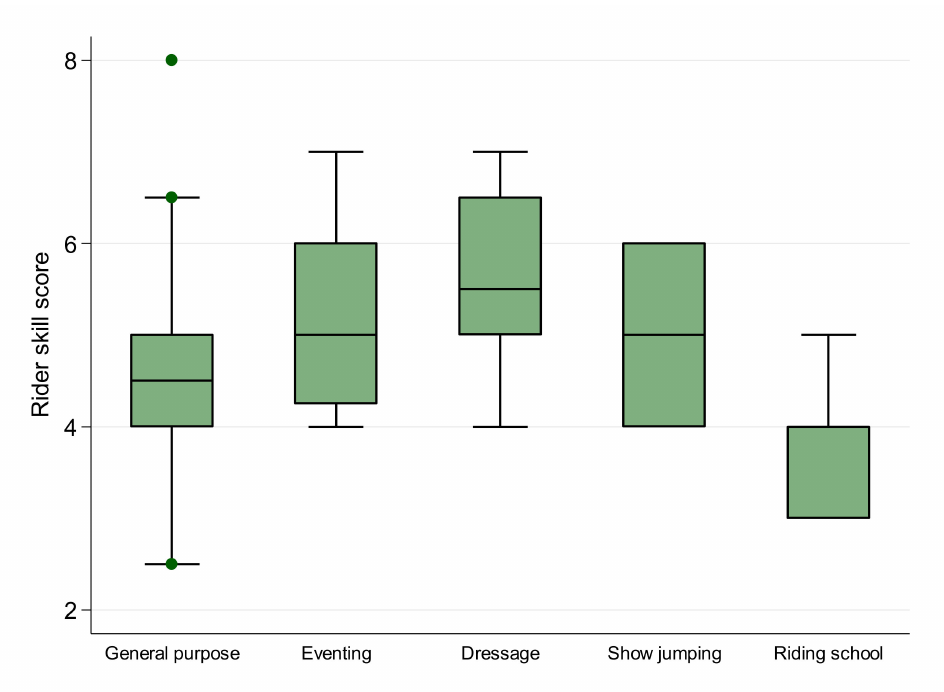
Figure 3. Median rider skill scores (0–10) of 60 riders across five equestrian work disciplines. Boxes represent medians and interquartile ranges, whiskers represent the range and individual points